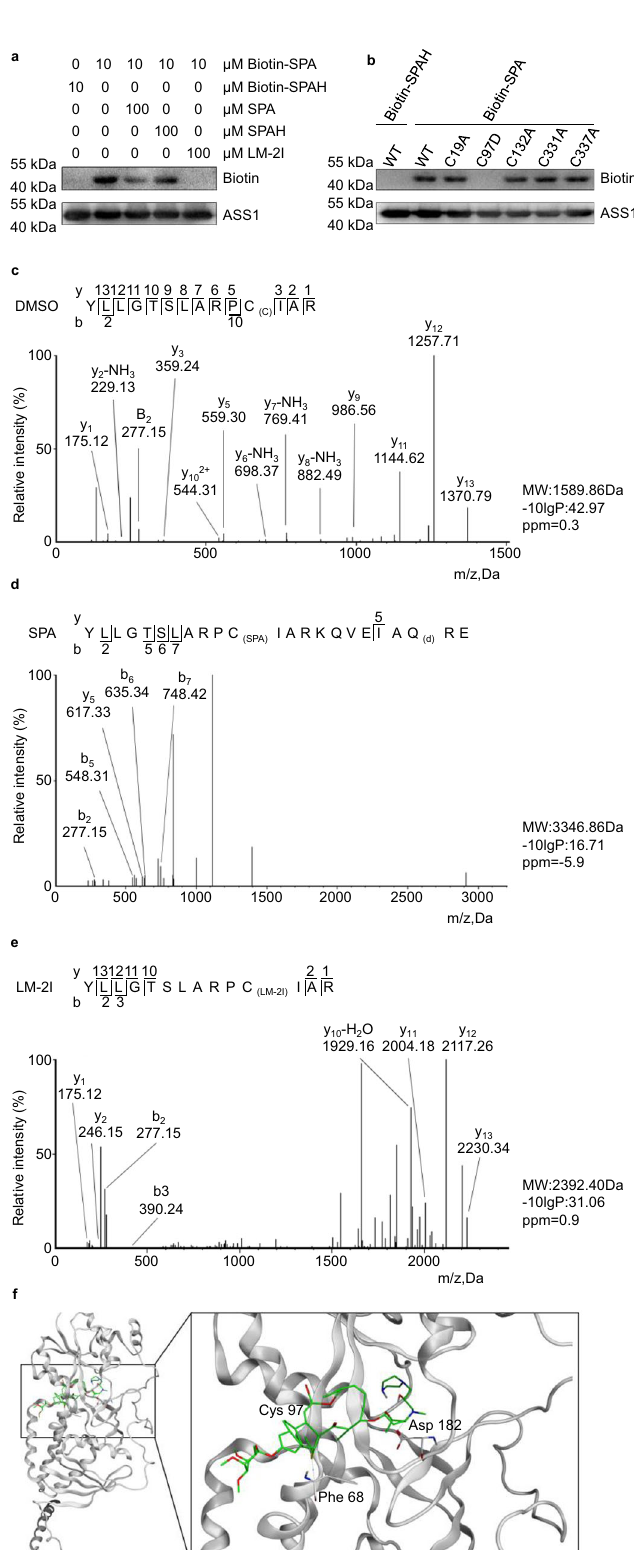
Fig. 3 SPA and LM-2I target ASS1 at C97 site. a The recombinant ASS1 protein was incubated with Biotin-SPA in the absence or presence of SPA, SPAH and LM-2I for 1 h at room temperature, followed by western blot using streptavidin-HRP or ASS1 antibody ( n = 3 biologically independent experiments). b Recombinant WT and mutant ASS1 proteins were incubated with Biotin-SPA or Biotin-SPAH for 30 min, followed by western blot using streptavidin-HRP or ASS1 antibody ( n = 3 biologically independent experiments). MS/MS analysis for the C97-containing peptide of recombinant ASS1 pre-incubated with vehicle ( c ), SPA ( d ), or LM-2I ( e ). (SPA) , combined with SPA; (LM-2I) , combined with LM-2I; (c) , carbamidomethylation; (d), deamidation. f Binding model of LM-2I-ASS1. The left panel is the global view of the entire ASS1 structure, the right panel is the focused view of LM-2I in the binding site (ASS1 in gray while LM-2I in green). Source data are provided as a Source Data fi